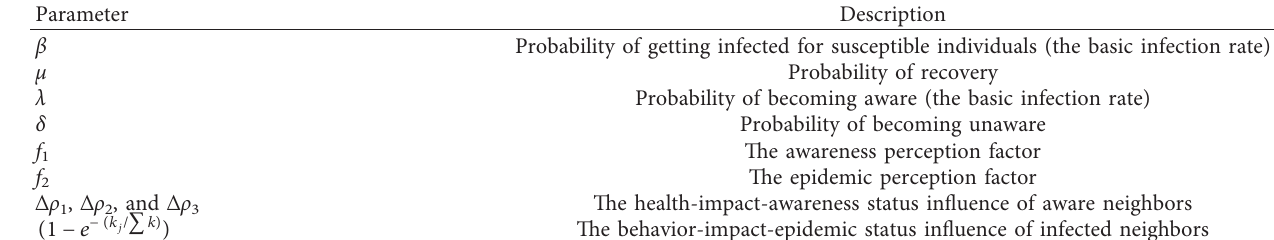
Table 2: The definitions of key parameters.